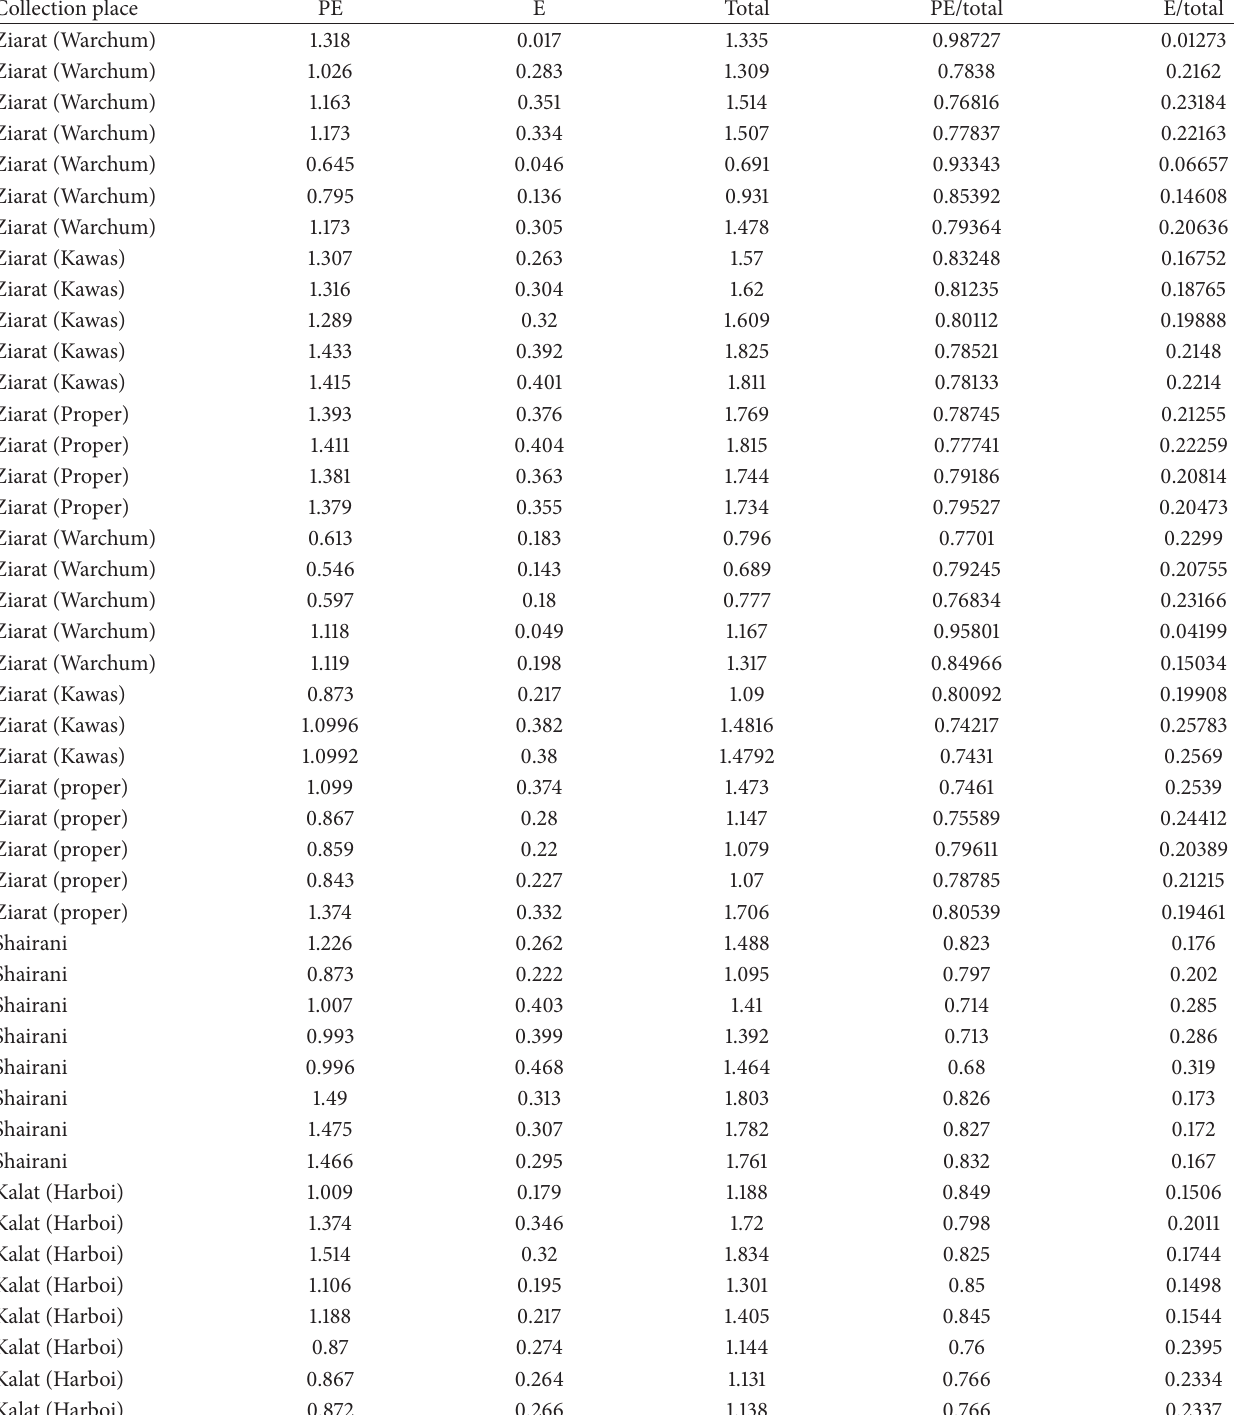
Table 1: Contents of two alkaloids in 45 Ephedra samples derived from the E. intermedia in (500mg